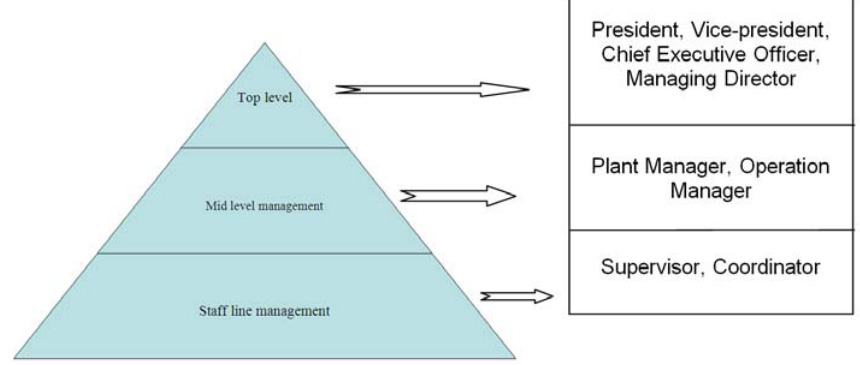
Fig. 1. Different level of manager and